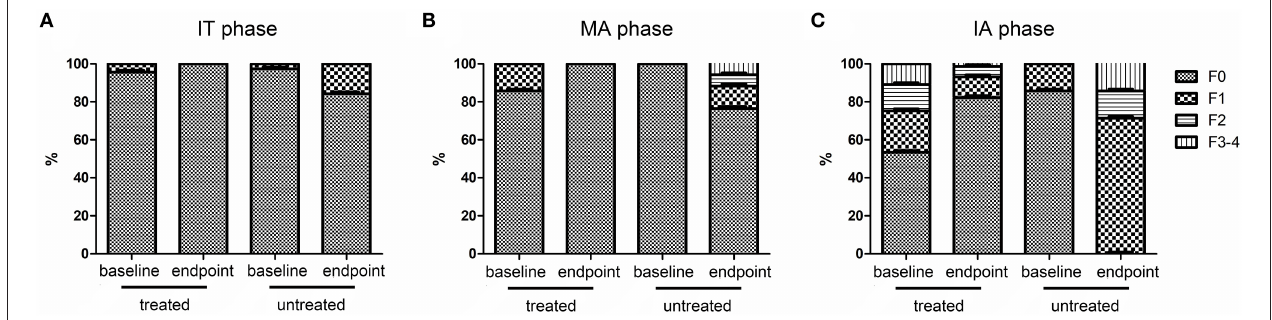
FIGURE 3 | Dynamics of fibrosis stage indicated by FibroScan from baseline to endpoint. IT, immune tolerant; MA, mildly active; IA, immune active.